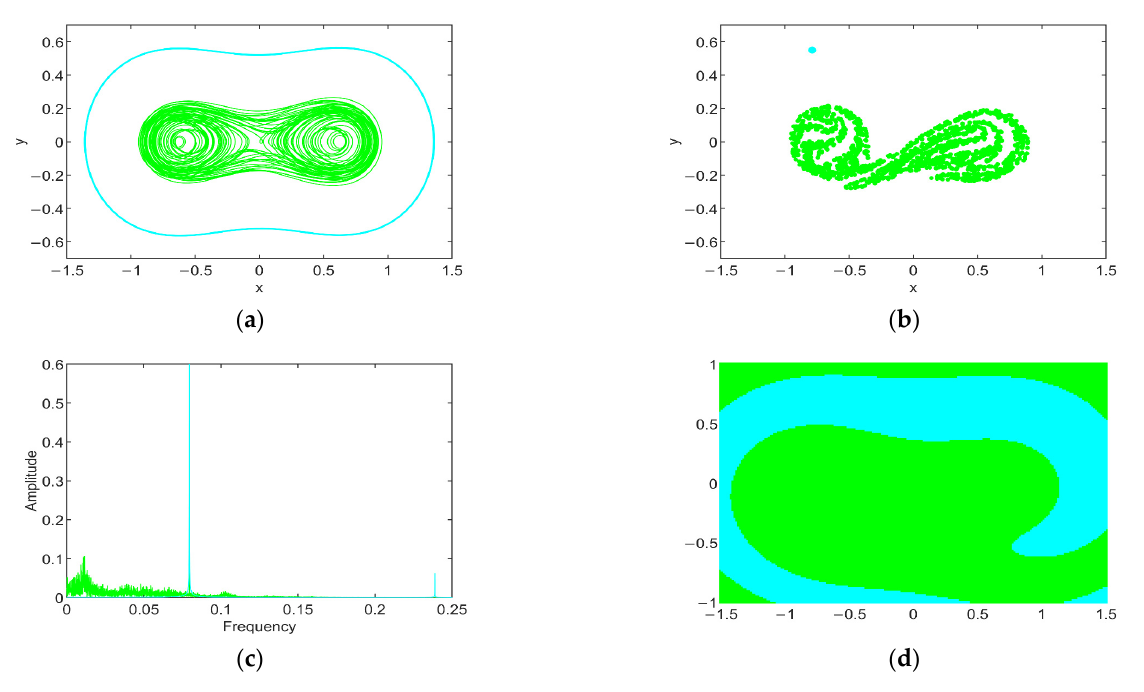
Figure 9. Bistable inter-well a tt ractors of the system (3) for 0.5 =ω and f 0 = 0.02: ( a ) phase map; ( b ) Poincare map; ( c ) frequency spectrum; and ( d ) basins of a tt raction.